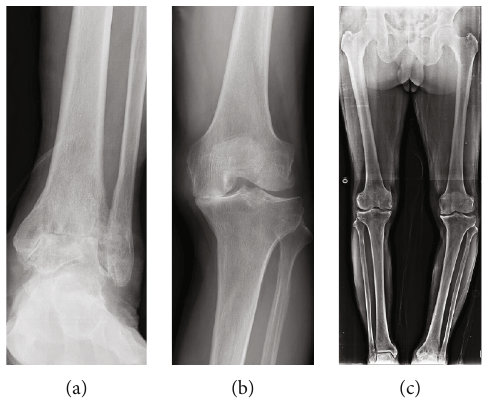
Figure 1: (a) An anteroposterior (AP) radiograph of a 72-year-old male patient who developed Takakura ’ s classi fi cation stage 4 osteoarthritic changes of the left ankle that failed to respond to conservative management. (b) An AP radiograph of Kellgren-Lawrence Grade IV osteoarthritic changes in the left knee (c) A preoperative standing AP radiograph of the bilateral lower extremities showed a left hip-knee-ankle (HKA) angle of 14.3 ° .